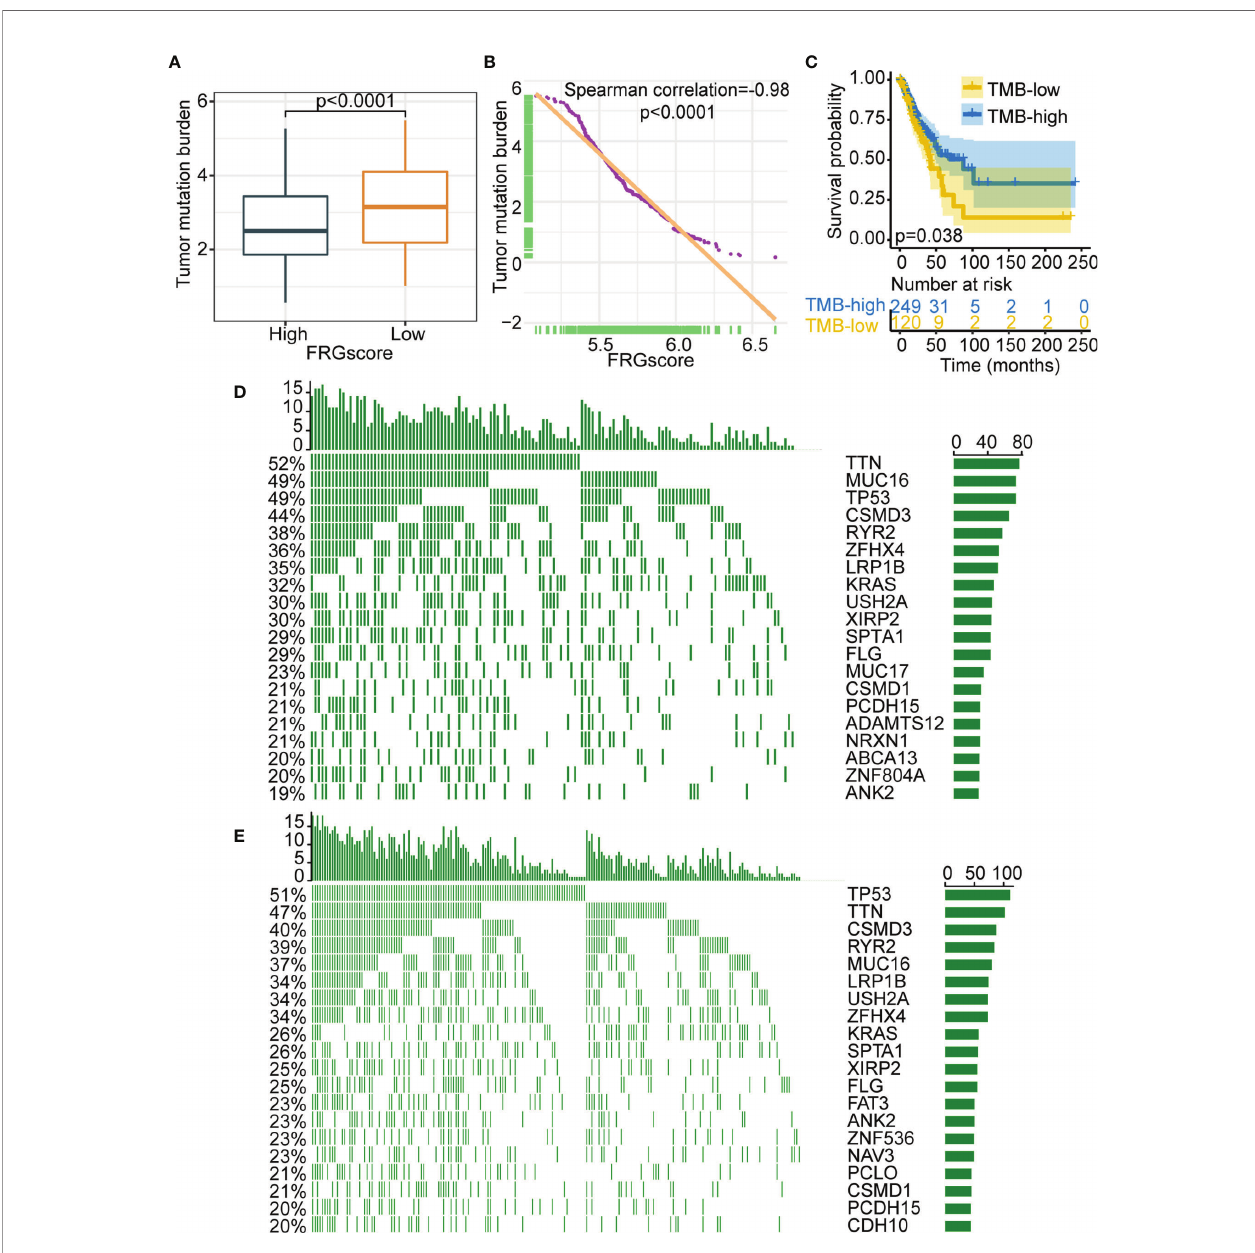
FIGURE 7 | Relationship between FRGscore and somatic variants. (A) Distribution of TMB in FRGscore-high and FRGscore-low subgroups. (B) Spearman ’ s correlation between FRGscore and TMB in TCGA cohort. (C) Kaplan – Meier curves of TMB-high and TMB-low subgroups in TCGA cohort. (D, E) Distributions of top 20 most frequently mutated genes in FRGscore-high subgroup (D) and FRGscore-low subgroup (E) . FRGscore, ferroptosis-related gene score; TMB, tumor mutational burden; TCGA, The Cancer Genome